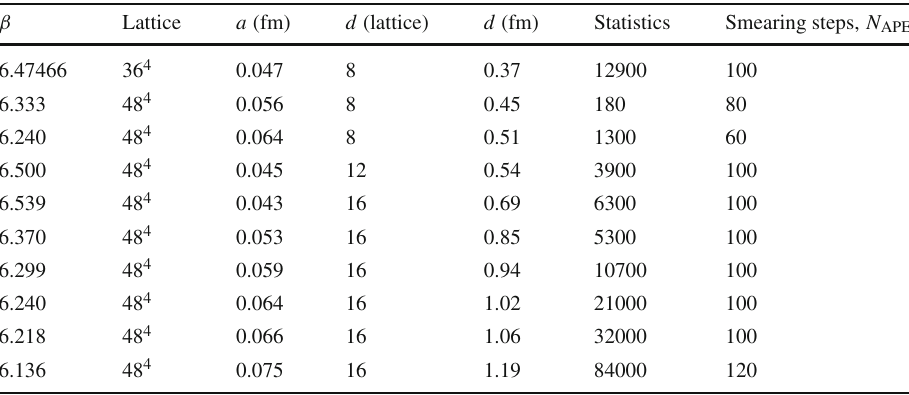
Table 1 Summary of the runs performed in the SU(3) pure gauge theory (measurements are taken every 100 upgrades of the lattice